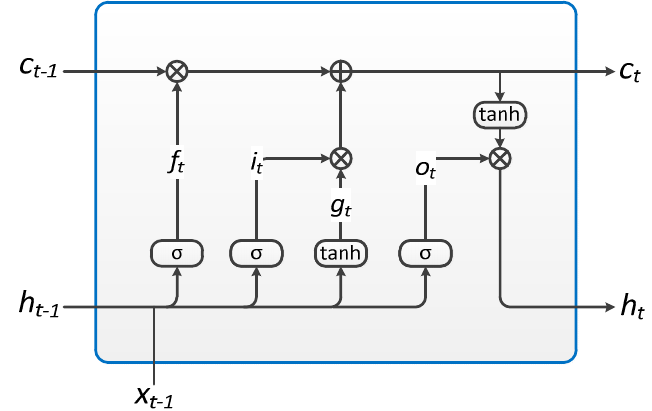
Figure 2. A long Short-Term Memory (LSTM) unit structure.